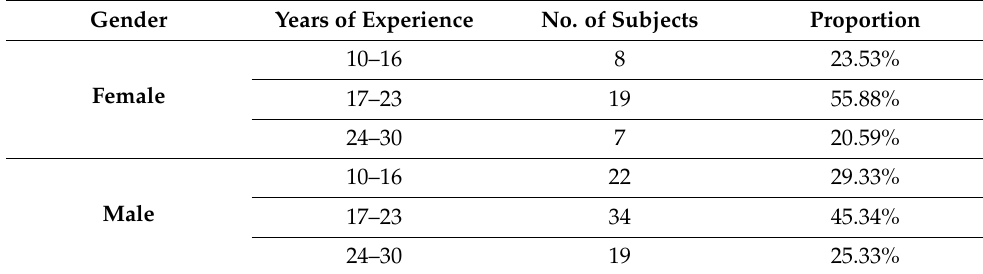
Table 2. Summary of respondents ( n =